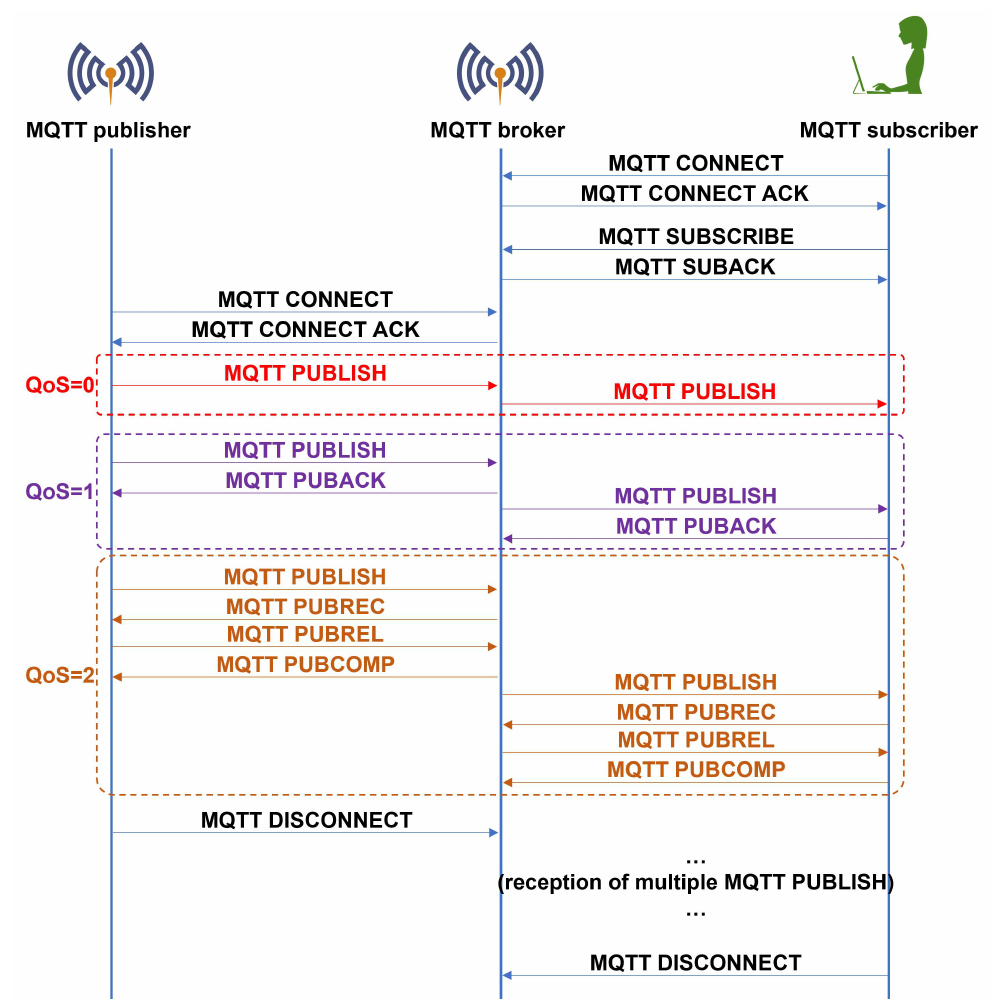
Figure 4. MQTT messages between publisher and subscriber through the